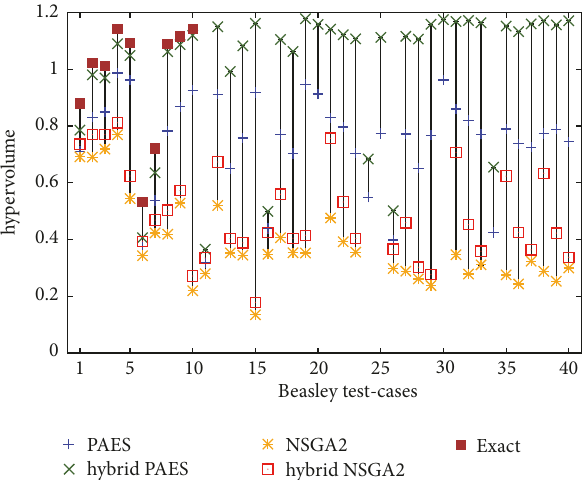
Figure 2: Average compared quality of the solution obtained by the different algorithms for 30 runs on the 40 Beasley benchmark test- cases (10 first ones for the Exact method). Quality of a solution is expressed as its